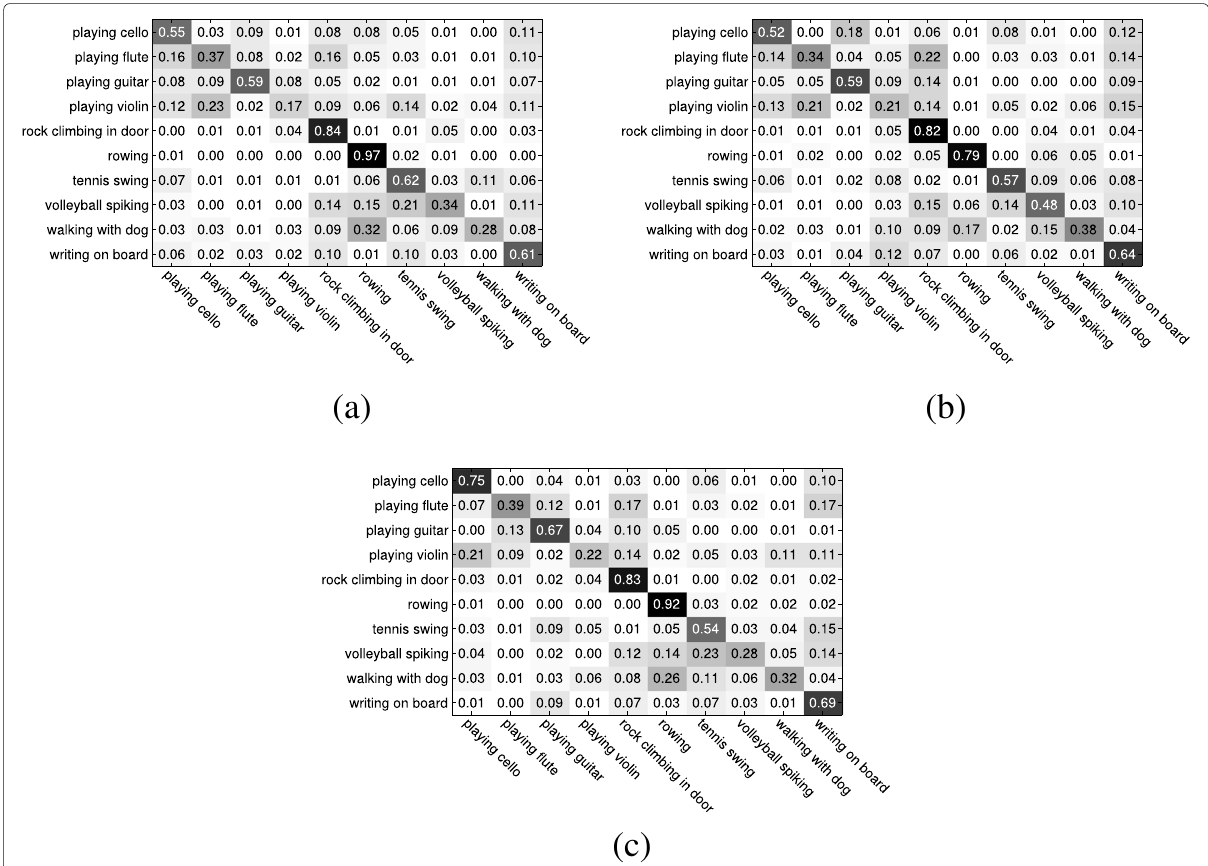
Fig. 8 Confusion matrices of ELP, CAP, and JCAEL on UCF ← PPMI4 when the ratio of labeled video data are set to 5%. a Confusion matrices of ELP. b Confusion matrices of CAP. c Confusion matrices of